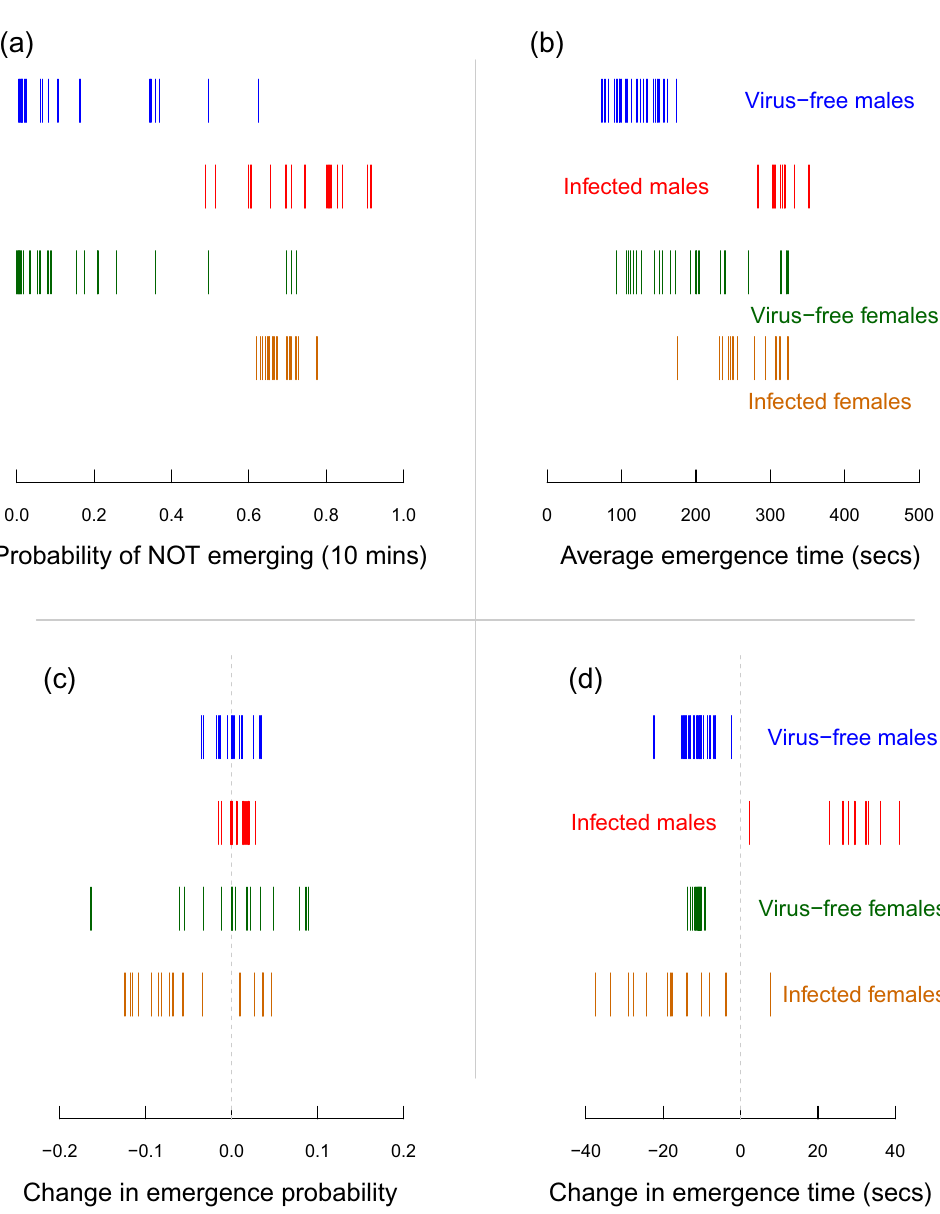
Figure 4. Estimated mean ‘personality scores’ for each individual cricket (vertical lines) for virus-free individuals and infected individuals, disaggregated by sex. From the top in each panel: blue = virus-free males, red = infected males, green = virus-free females, and brown = infected females. These estimates were derived from the four model parameters that included an individual-level random effect: ( a ) binomial intercept, ( b ) continuous intercept, ( c ) binomial slope, and ( d ) continuous